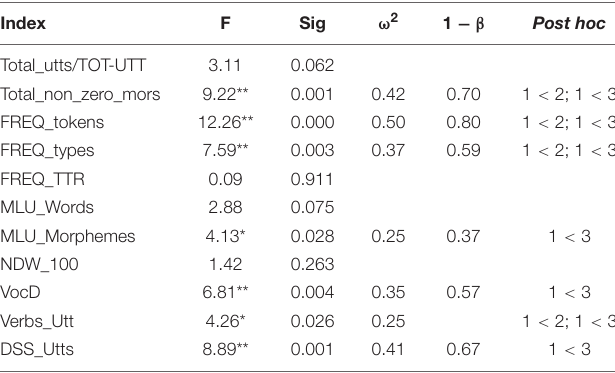
TABLE 1 | One-way analysis of variance summary table comparing different difficulty levels in regard to the eleven linguistic